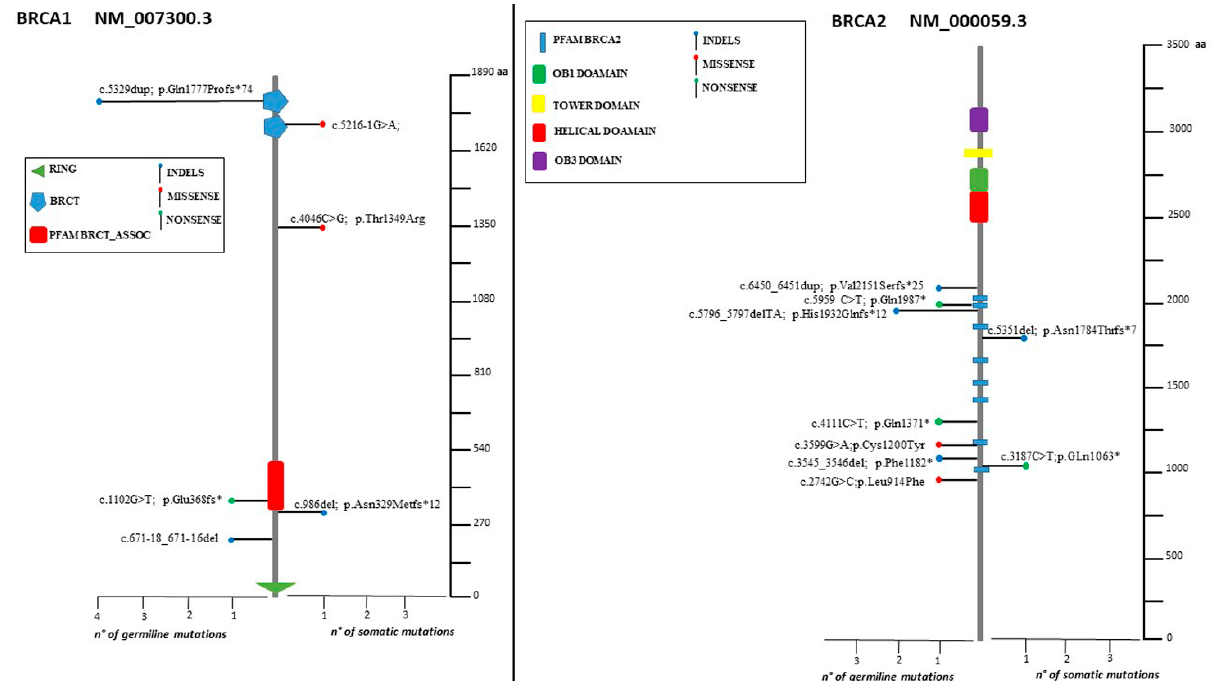
Figure 2. Lolliplots showing germline and somatic variant spectrum (both pathogenic and VUS) throughout the whole protein sequences of BRCA1 and BRCA2 . The vertical black scale bar represents the length (amino acids) of the protein sequence. The horizontal bar represents the number of patients affected by the specific mutation. Each lolliplot represents a variant identified in this study. The blue lolliplot identifies a shorts indels mutation (deletion or duplication). The red lolliplot indicate a missense variant, while the green ones a nonsense